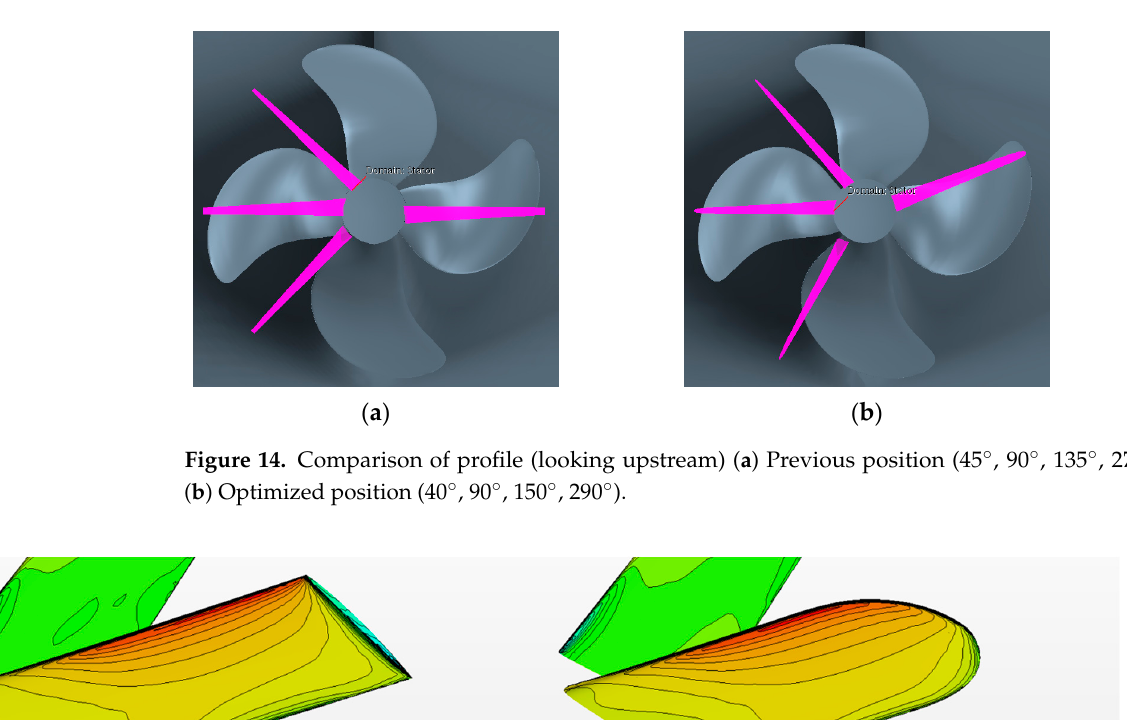
Figure 13. Illustration of the difference in the flow angle between the stator and propeller position ( fourth blade stator).